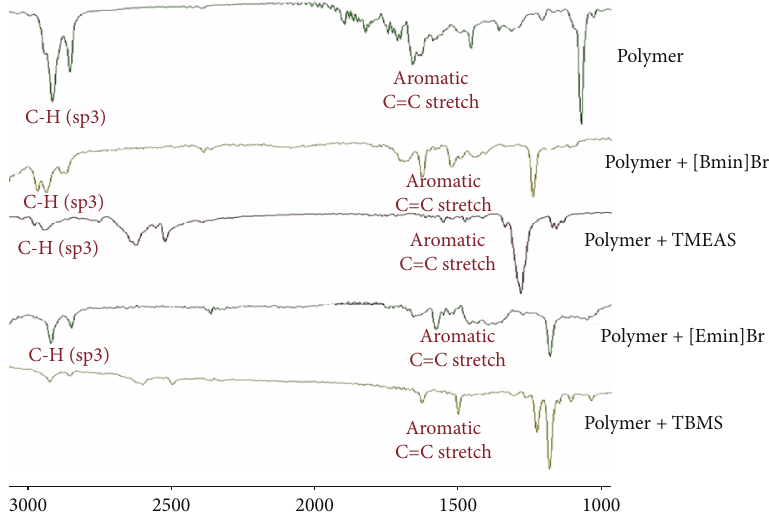
Figure 3: FTIR spectra of the polymer and polymer-IL (1 wt%) mixtures.